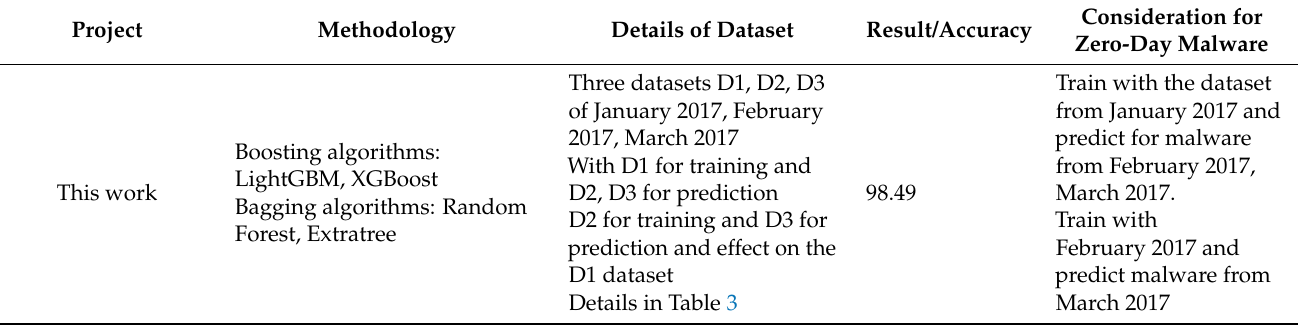
Table 12. Comparison with five zero-day malware